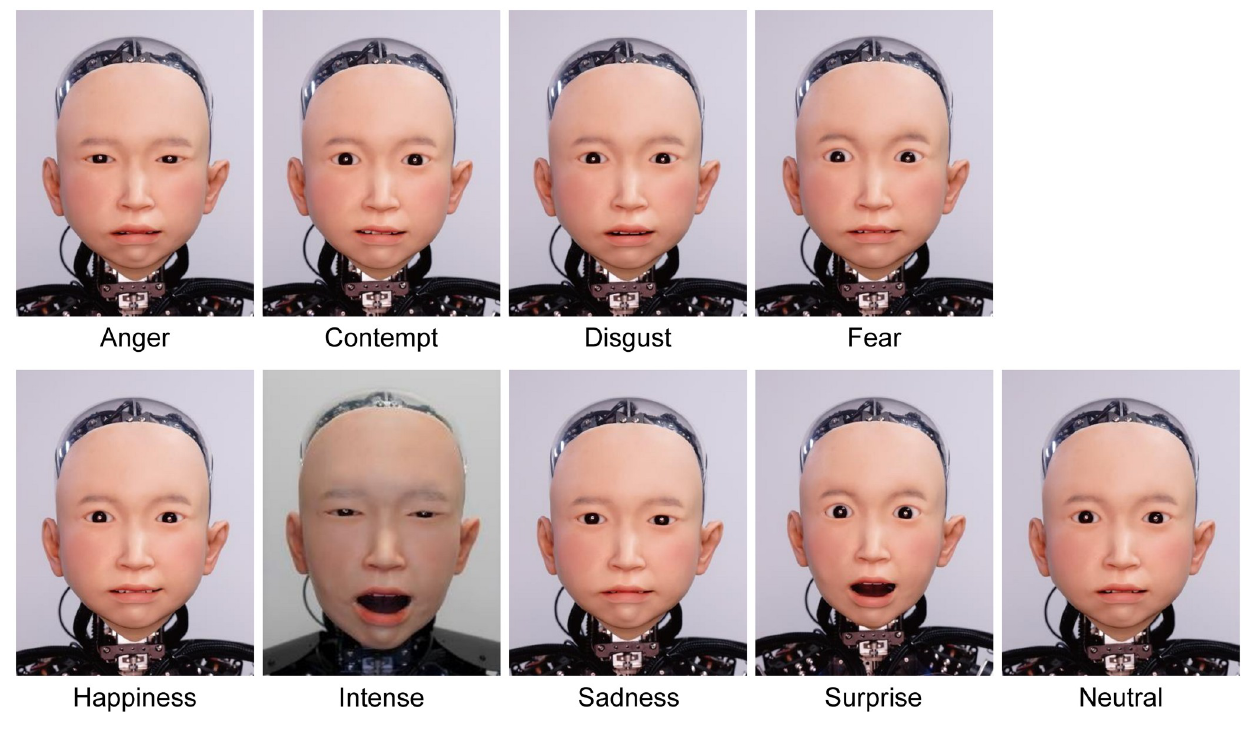
Fig 1. Nine facial expressions of ibuki